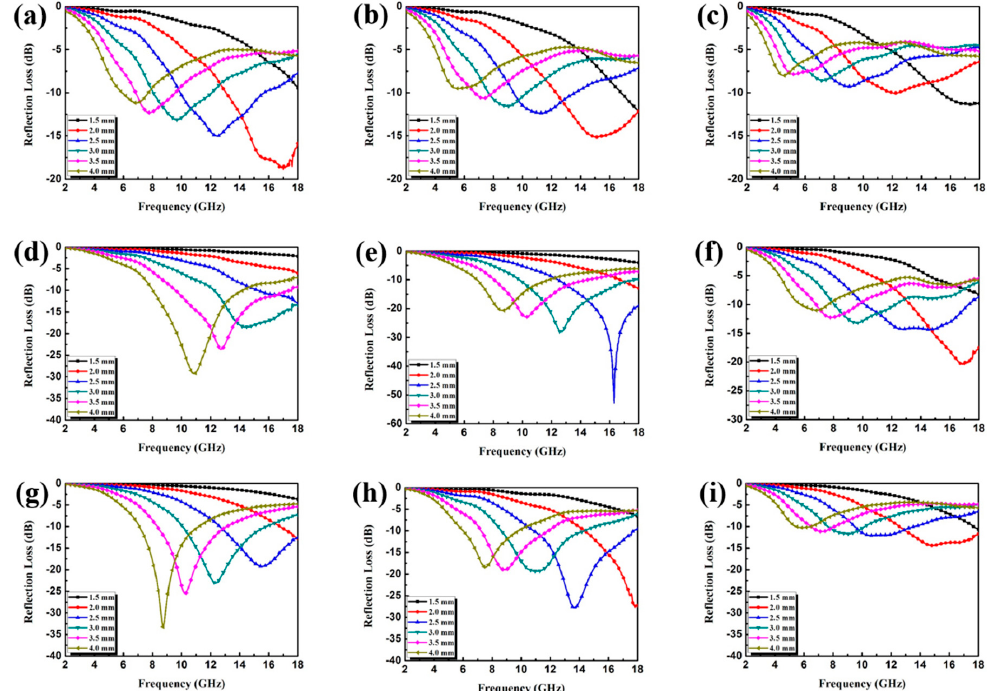
Figure 7. Reflection loss curves of paraffin composites containing ( a ) 15 wt %, ( b ) 20 wt %, and ( c ) 30 wt % Sample A; ( d ) 15 wt %, ( e ) 20 wt %, and ( f ) 30 wt % Sample B; ( g ) 15 wt %, ( h ) 20 wt %, and ( i ) 30 wt % Sample C.